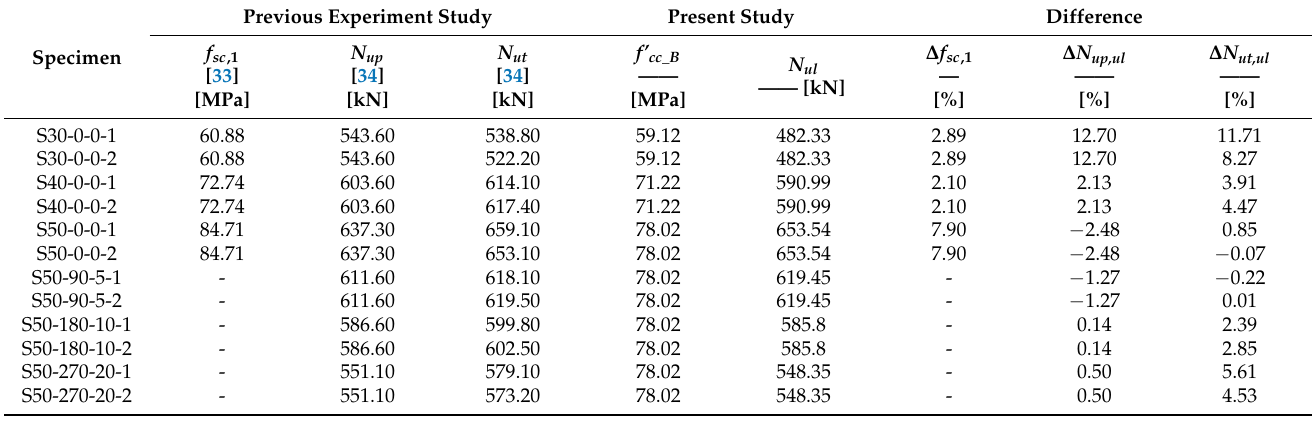
Table 1. Comparison of the ultimate loading-capacity calculation.